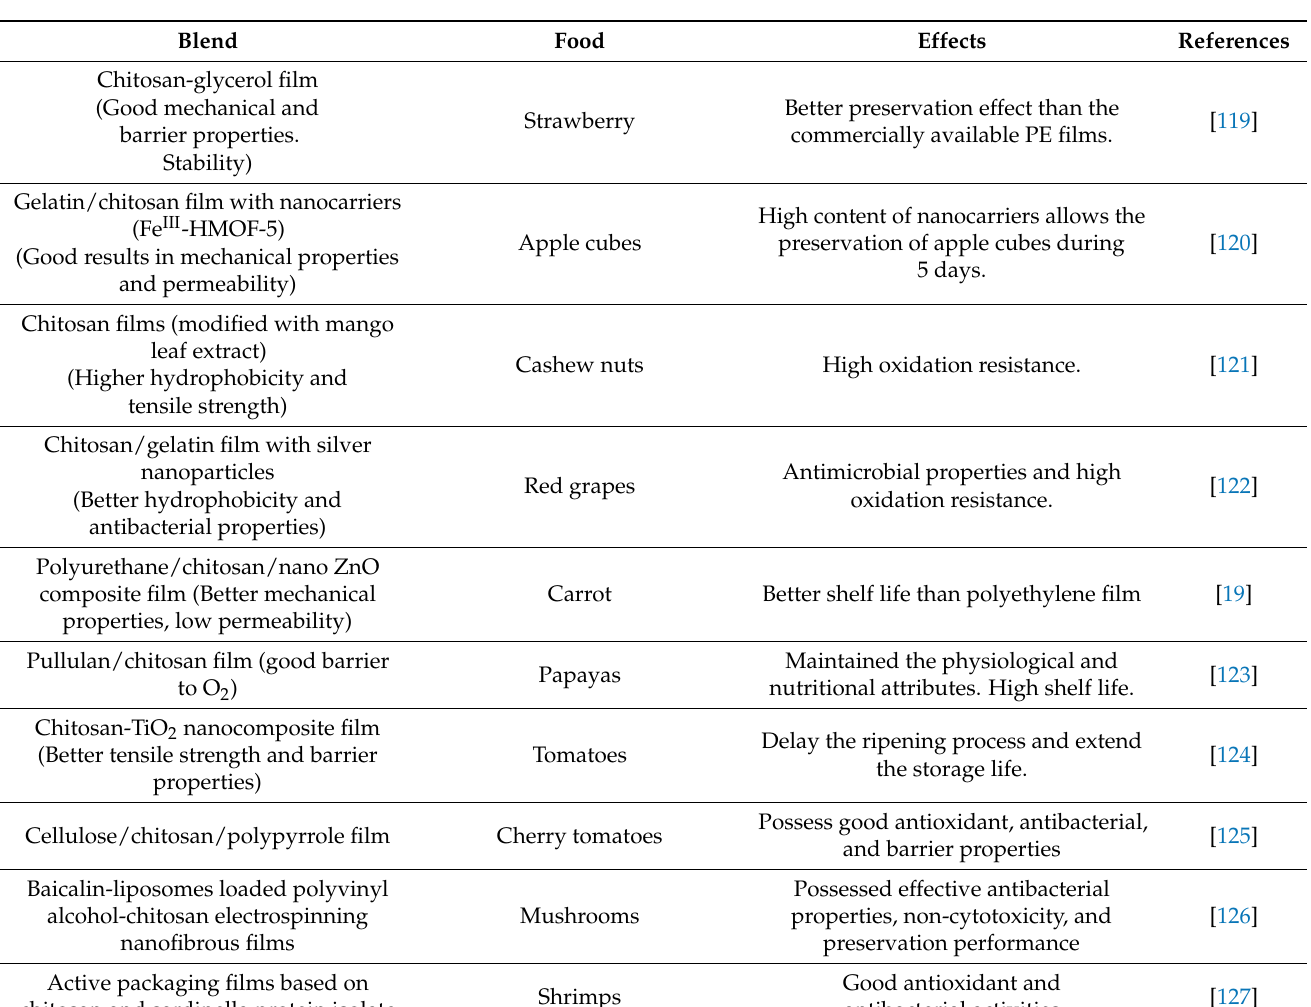
Table 5. Effects of films based on chitosan over